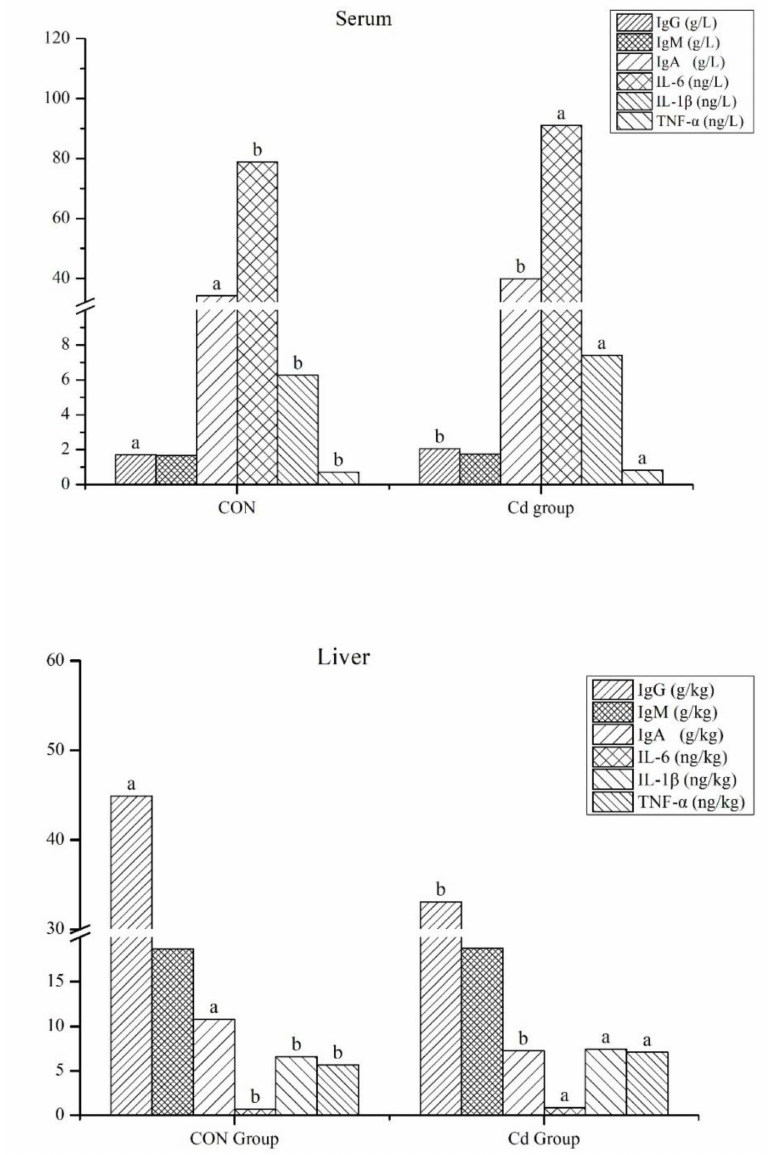
Figure 3. Immune functions in the goat serum and liver. IgG, Immunoglobulin G; IgM, Immunoglob- ulin M; IgA, Immunoglobulin A; IL-6, interleukin 6; IL-1 β , interleukin-1 β ; TNF- α , tumor necrosis factor-alpha. CON Group, the control group; Cd Group, the cadmium group. Different small letters of superscript indicate significant differences ( p < 0.05), and the same small letters or no letters indicate no significant difference ( p >